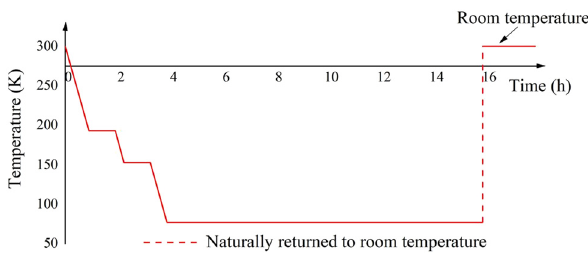
Figure 1: Programme chart of cryogenic temperature control of